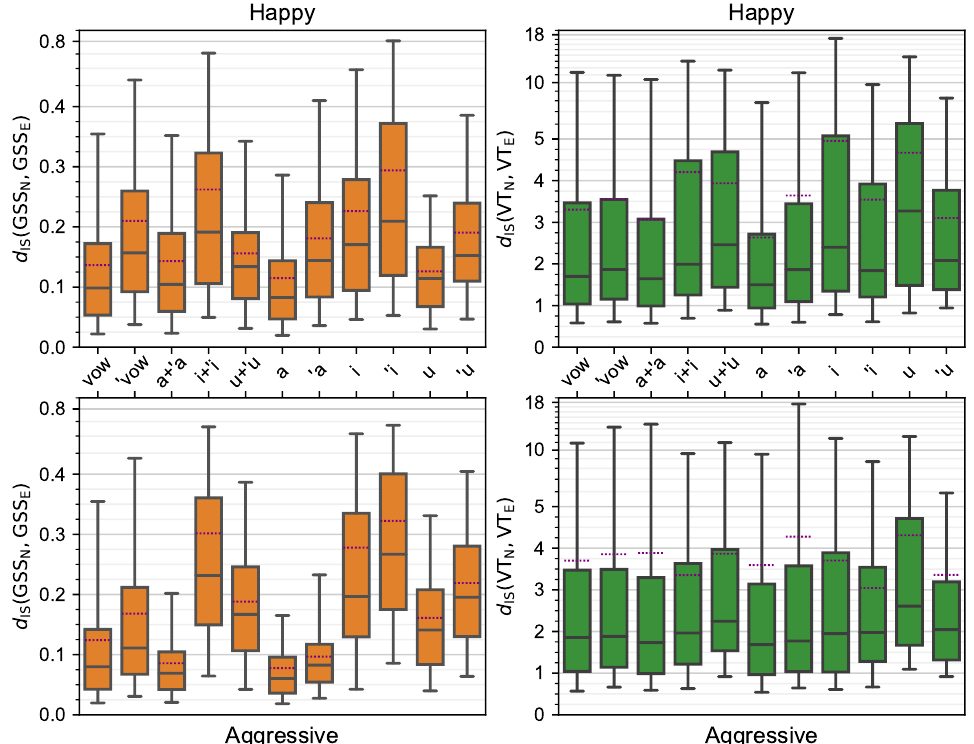
Figure 3. Boxplots of the Itakura–Saito distances from GSS N to GSS E (first column) and from VT N to VT E (second column), for happy (first row) and aggressive (second row) vowels. Dotted lines represent the mean of the distributions, and whiskers are set to 5th and 95th